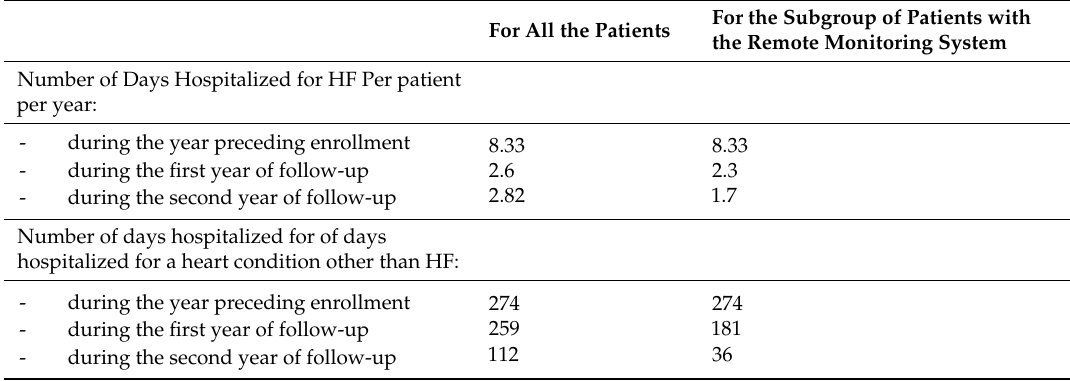
Table 5. Comparison of the means “number of days hospitalized for HF per patient per year” and “number of days hospitalized for a heart condition other than HF” for all patients and for the subgroup of patients with remote monitoring